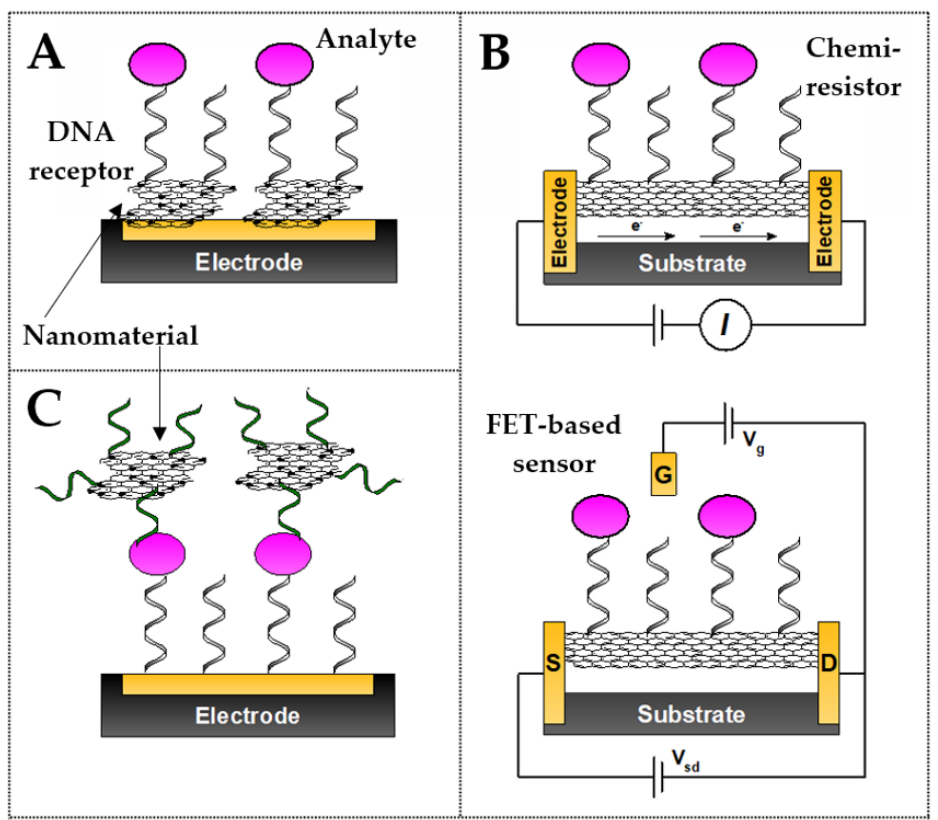
Figure 2. Main approaches to the application of nanomaterials in DNA sensor design. ( A ) Carbon nanomaterials as intermediate layers, ( B ) nanomaterials as transducers or their main components in chemoresistor ( top ) and FET-based ( bottom ) DNA biosensors, and ( C ) carbon nanomaterials as labels responsible for electrochemical signal.